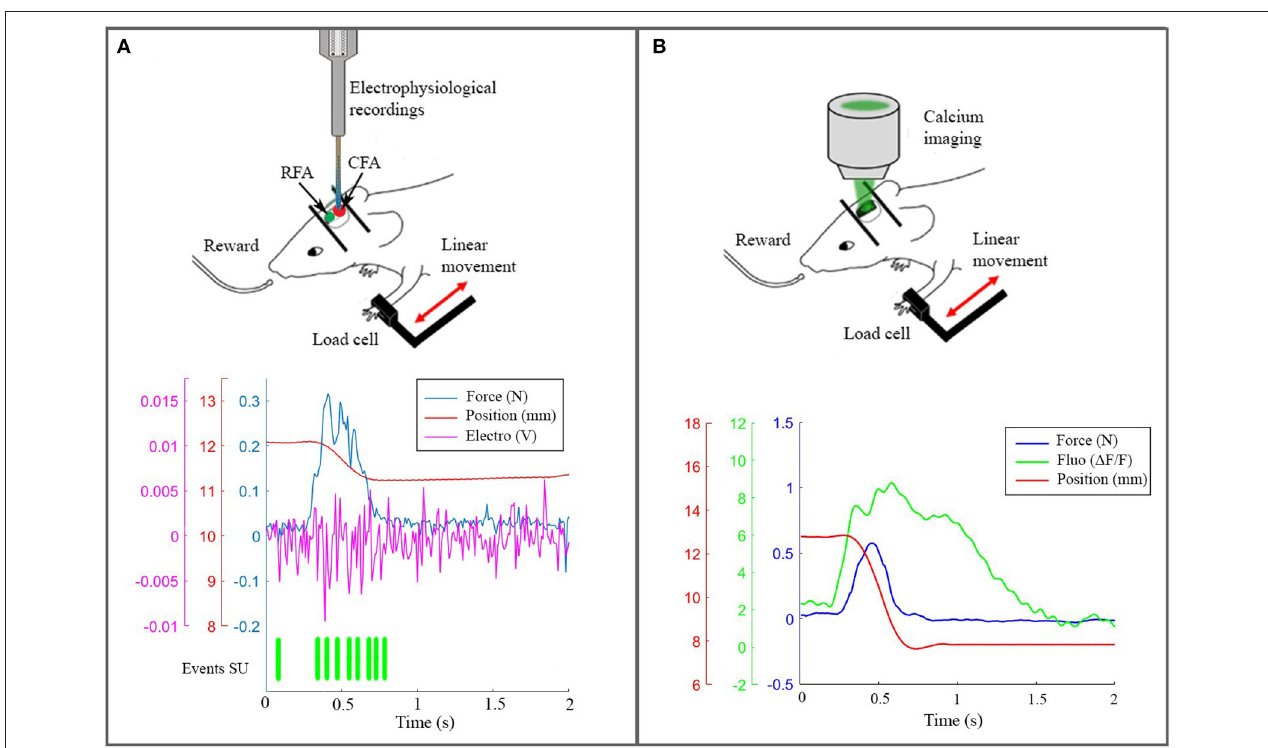
FIGURE 3 | The real robotic platform. (A) On the top a schematic representation of the experiment during electrophysiological recording in CFA. At the bottom the synchronized data: force peak (blue), movement of the slide (red), high frequency electrophysiological signal of a single channel (magenta) and the timestamp of a selected single unit. (B) On the top a scheme of the experiment with the setup to record calcium activity. At the bottom the recorded data after synchronization: force peak (blue), movement of the slide (red) and calcium response (green).